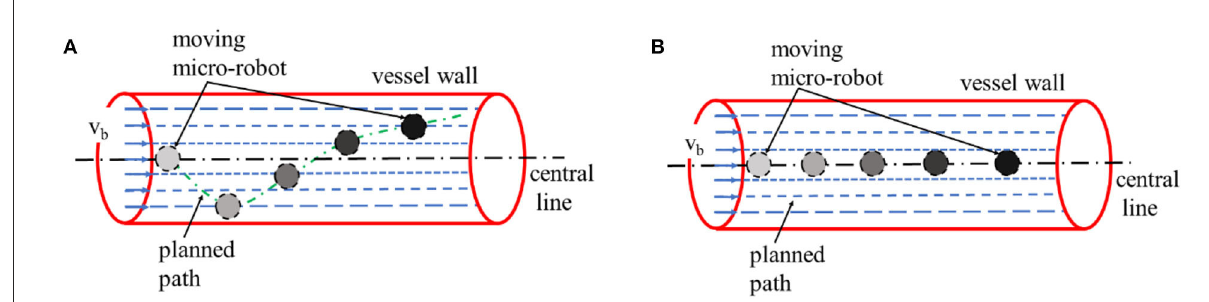
FIGURE1 A schematic diagram for: (A) a micro-robot moving along a random route; (B) a micro-robot moving close to the central line of